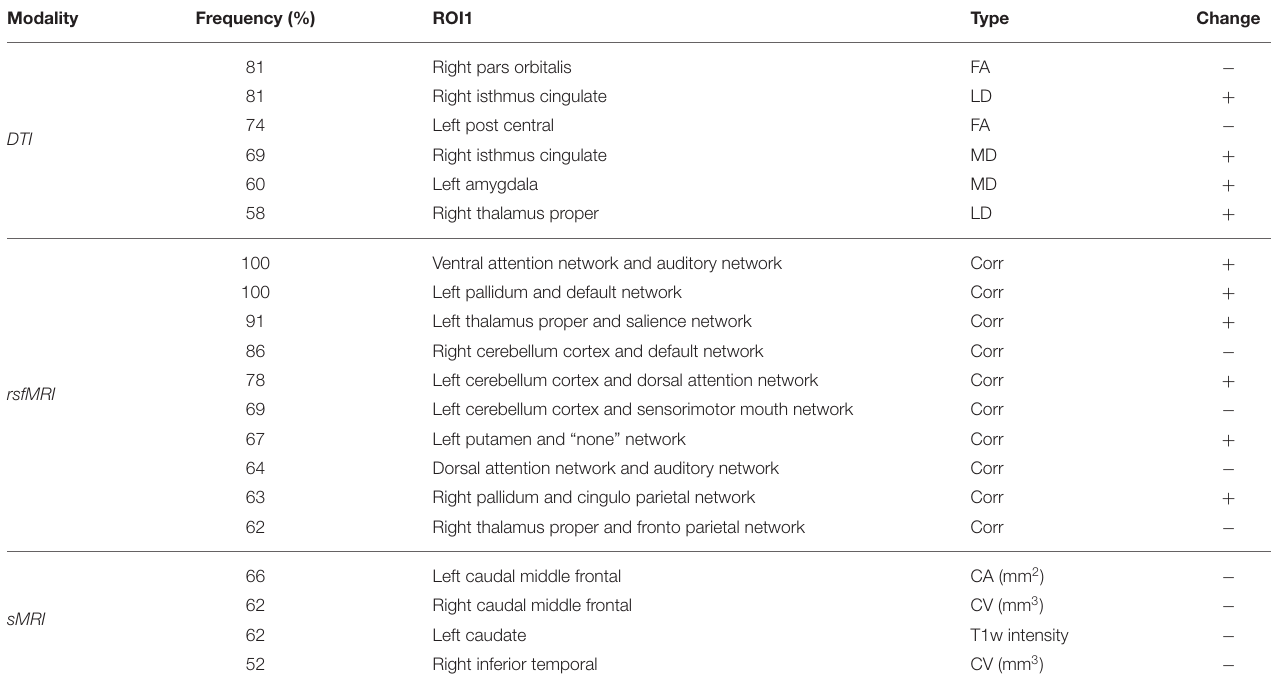
TABLE 2 | Summarized predictors selected from multimodal MRI.